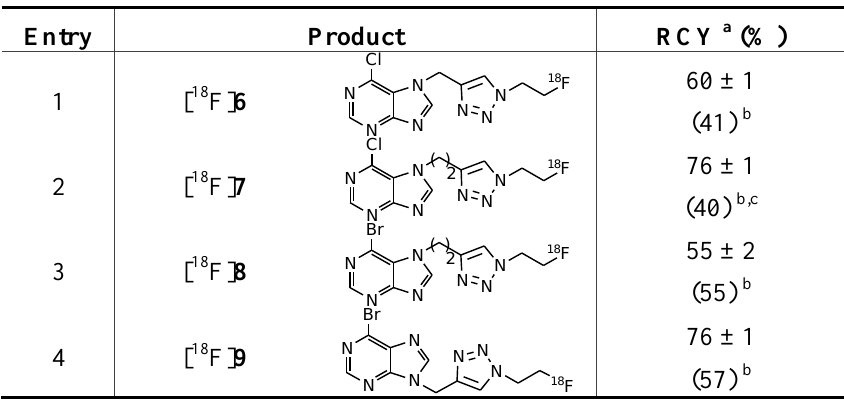
Table 1. Radiochemical yields for formation of [ 18 F] 6 –[ 18 F] 9